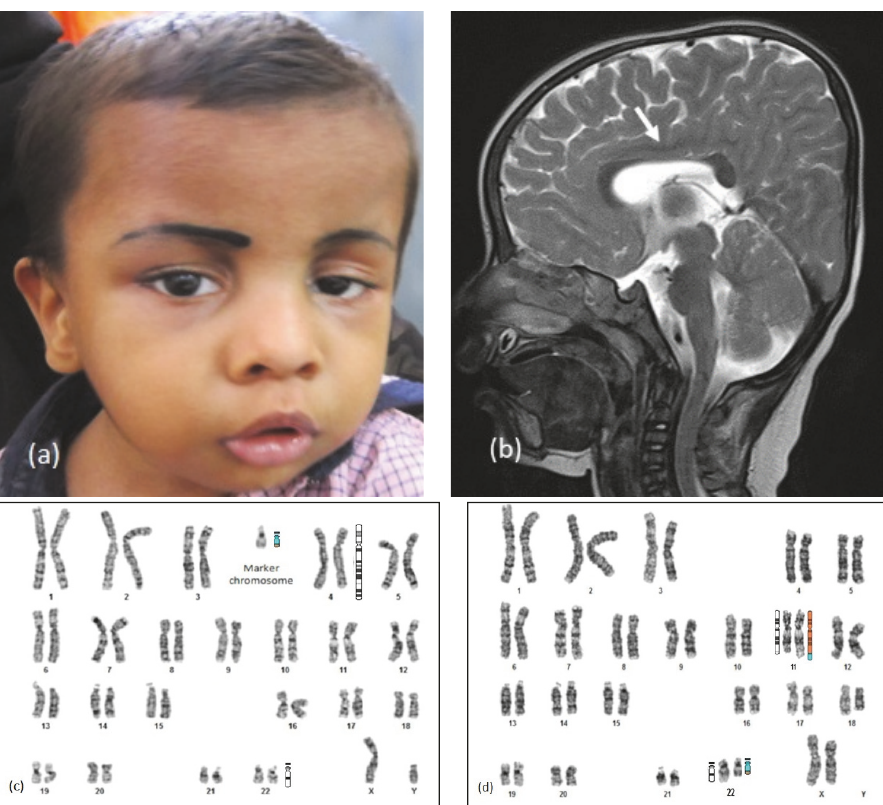
Figure1:Proband1withEmanuelsyndrome:(a)phenotypewithunilateralleftptosis,microretrognathia,(b)T2weightedmagneticresonance imaging of brain (sagittal) showing hypoplastic body of corpus callosum (arrow), (c) karyotype and ideogram showing marker chromosome, and (d) karyotype and ideogram of mother showing t(11; 22)(q24;